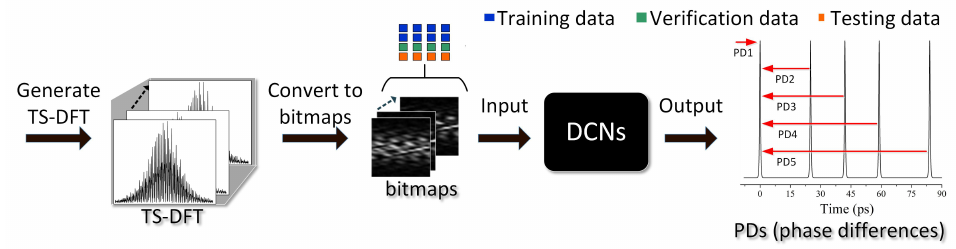
Figure 1. Processing flow for TS-DFT data for the soliton molecules based on the neural